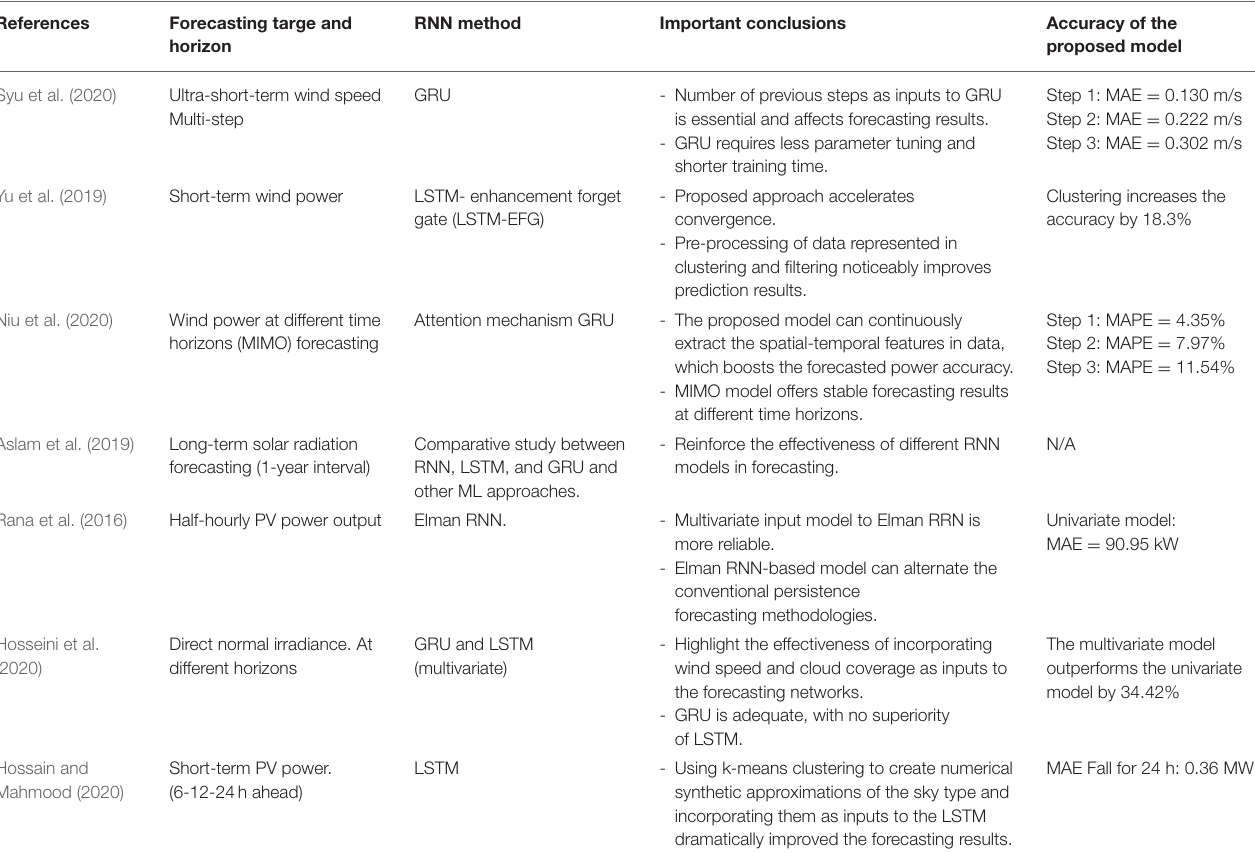
TABLE 2 | Summary of recurrent neural network (RNN)